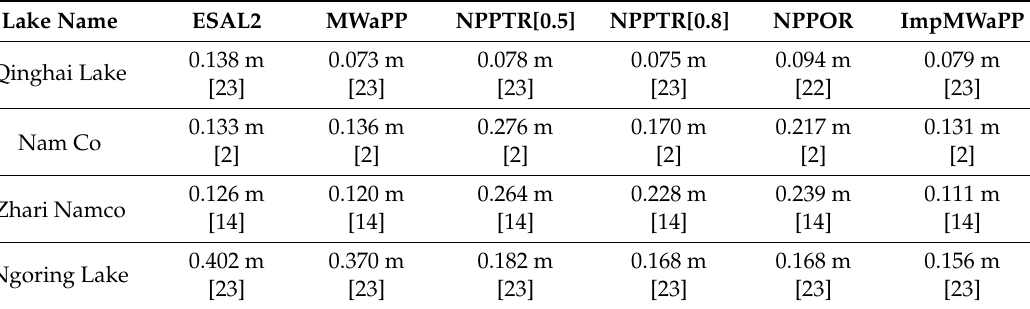
Figure 10. Spatial distribution of deviations between Cryosat-2 time series for Ngoring derived from different retrackers and in situ data: ( a ) ESAL2; ( b ) MWaPP; ( c ) NPPTR[0.5]; ( d ) NPPTR[0.8]; ( e ) NPPOR; ( f ) ImpMWaPP. Table 3. RMSEs between Cryosat-2 time series and in situ data: icing period.